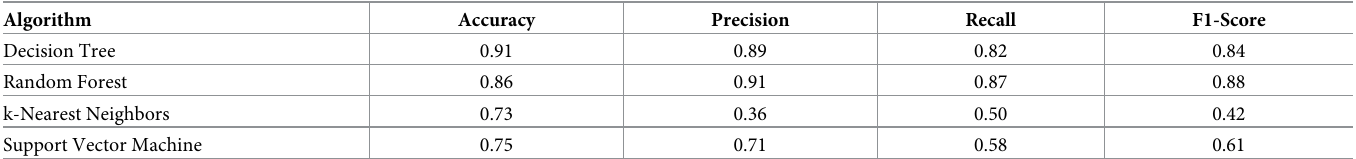
Table 2. Macro average performance measures of machine learning algorithms on extended feature set trained classifiers using San Diego cohort data (1998-2019).